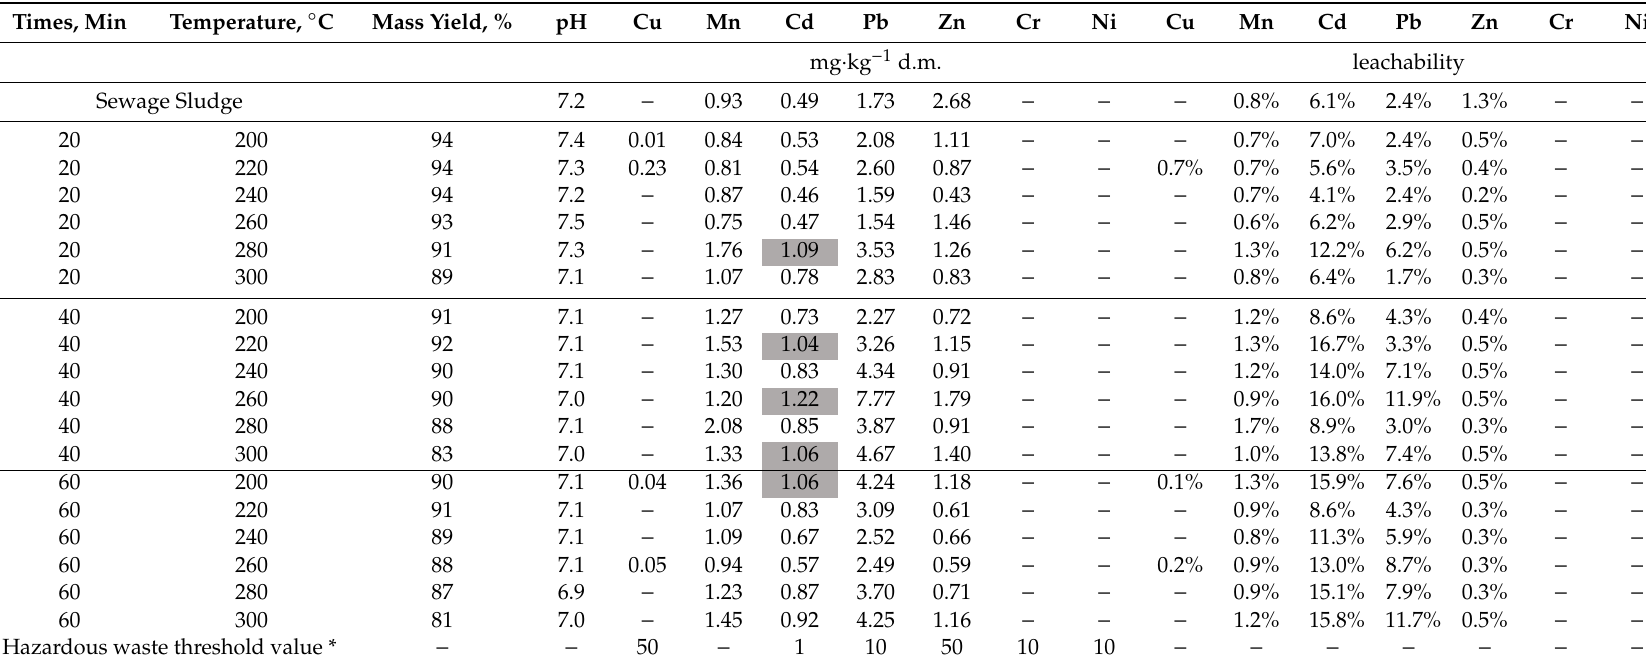
Table 3. Mean values of heavy metal leachability and pH from water extracts of raw sewage sludge and torrefied SS obtained from torrefaction of sewage sludge in six temperature variants, with three retention times; ( − ) indicates the value was below the detection level of 0.01 mg · kg − 1